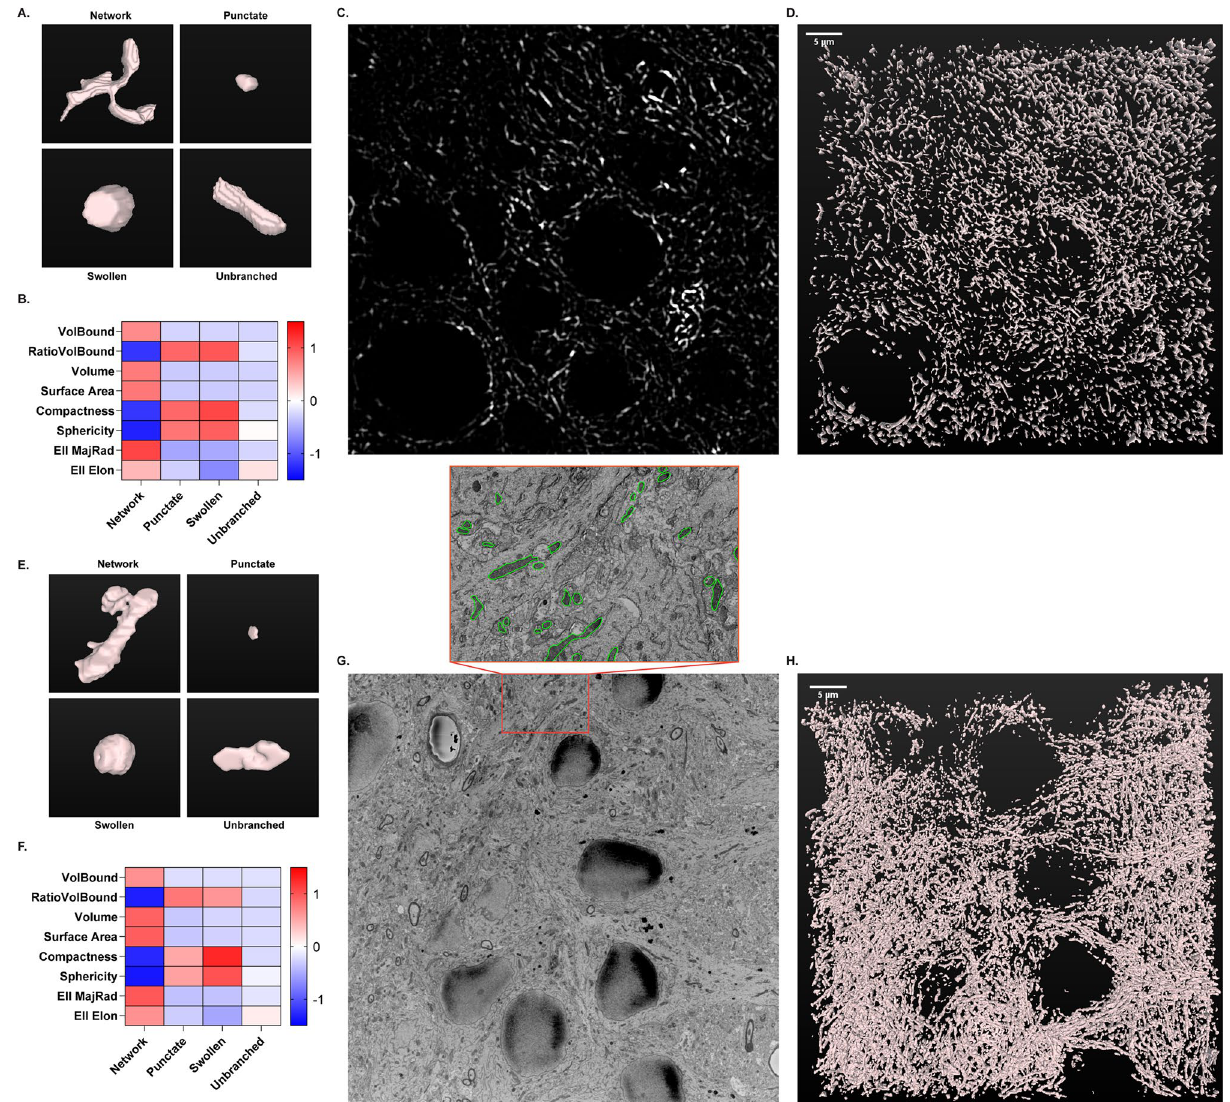
labeled for ATP synthase and imaged using confocal microscopy. ( B ) Heatmap displaying the scaled 8 size and shape measurements by morphology for confocal microscopy. ( C ) Representative confocal image of ATP synthase immunofluorescence from mouse hippocampus. ( D ) 3D rendering of mitochondria from the full z-series (50 slices, 5 µm) of the image shown in ( C ), acquired via confocal microscopy. ( E ) Representative 3D renderings of individual mitochondrial objects from rat brain tissue acquired via serial block-face scanning electron microscopy (SBF-SEM). ( F ) Heatmap displaying the scaled 8 size and shape measurements by morphology for SBF-SEM. ( G ) Representative single-plane image from SBF-SEM z-series. Insert: Enlarged area of representative image with mitochondria traced (green). ( H ) 3D rendering of mitochondria from the full z-series (100 slices, 7 µm) of the image shown in ( G ), acquired via